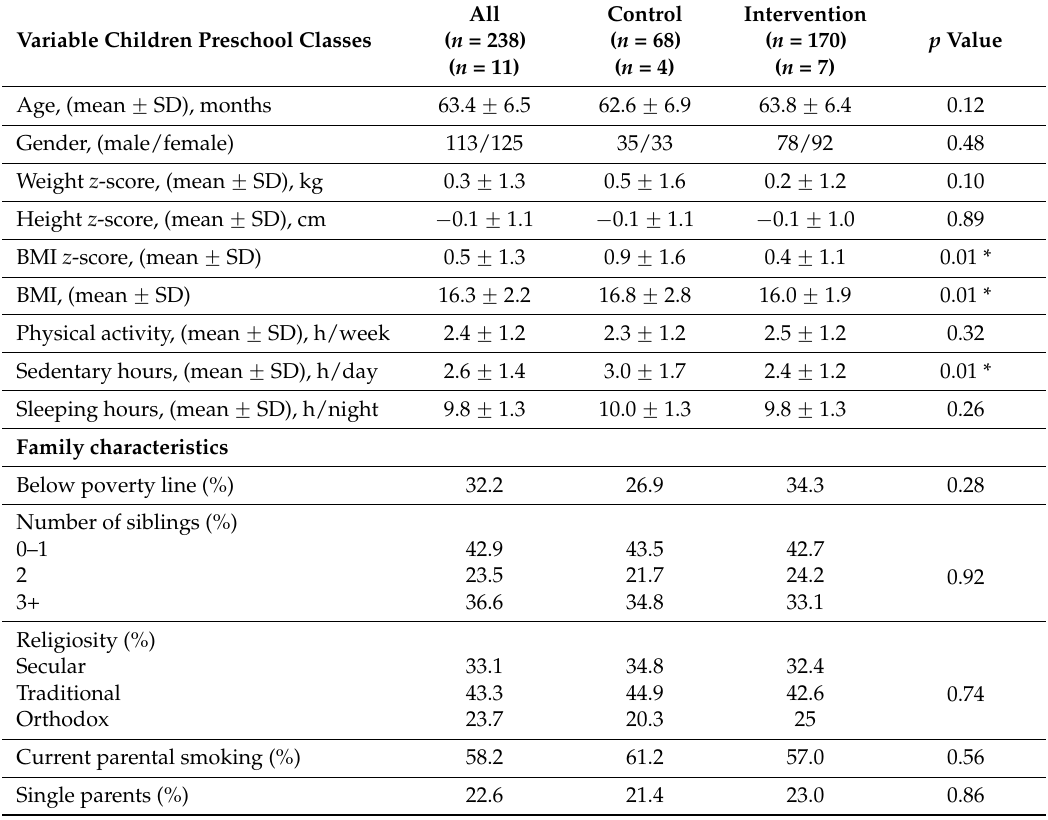
Table 1. Selected baseline characteristics of the study participants by study arm ( n = 238).